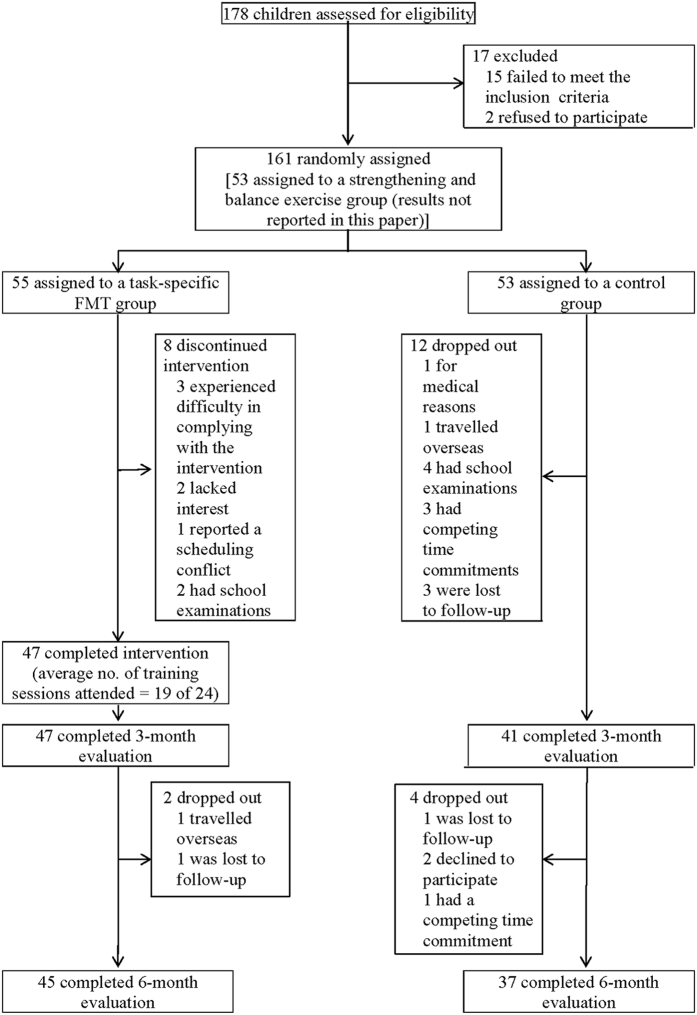
Participant flow.